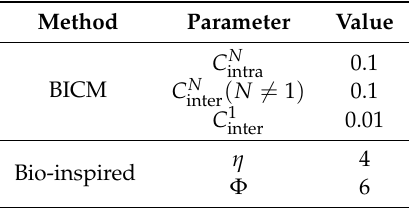
Table 1. Parameter settings. BICM, brain-inspired configuring